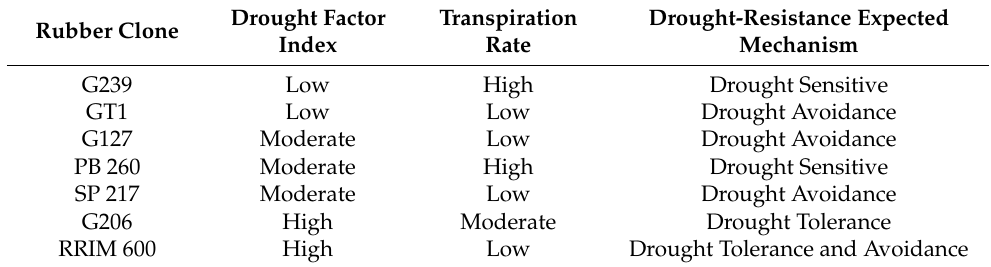
Table 2. Drought-resistance expected mechanism of seven rubber clones with contrasting DFI. Drought Factor Transpiration Drought-Resistance Expected Rubber Clone Index Rate Mechanism G239 Low High Drought Sensitive GT1 Low Low Drought Avoidance G127 Moderate Low Drought Avoidance PB 260 Moderate High Drought Sensitive SP 217 Moderate Low Drought Avoidance G206 High Moderate Drought Tolerance RRIM 600 High Low Drought Tolerance and